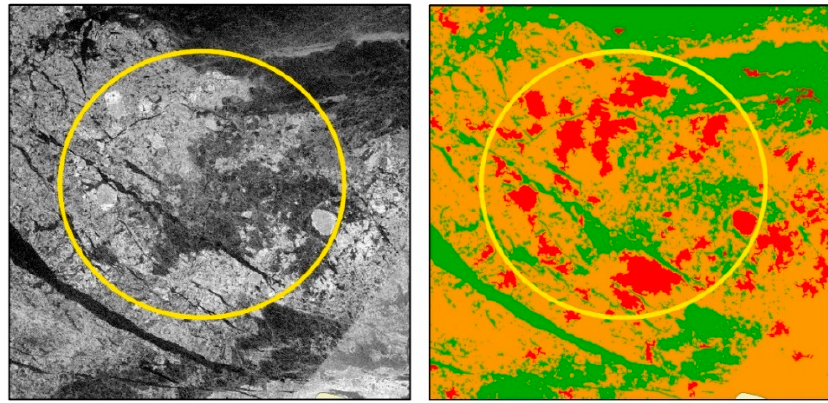
Figure 8. Enlargement of the area marked by the yellow circle in Figure 7g and the corresponding map of ice types from the TEMS-N method. The color code is the same as in Figure 7.